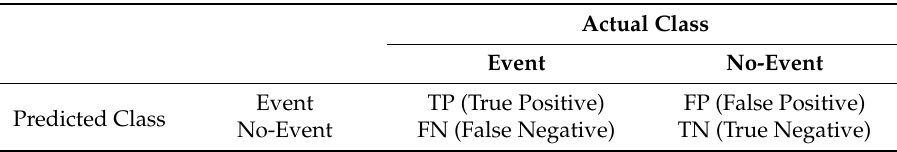
Table 1. Confusion